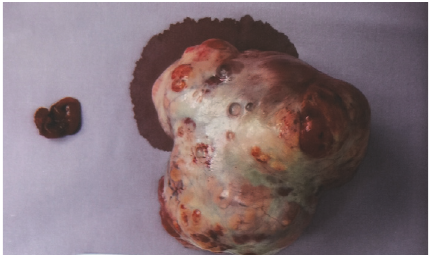
Figure 3: The specimen showed the left ovarian tumour and fallopian tube of the patient. The gross specimen consisted of a lobulated mass 100 x 100 x 30 mm with a defect measuring 20 mm in size externally, altogether weighing 177 grams. The mass had morcellated appearance. On cut section had solid and multi- cystic appearance. The solid areas had a golden yellow appearance punctuated by foci of haemorrhage. A small fleshy tan solid-cystic area was present at one end measuring 20 x 15 x 15 mm. In cytological examination, the sections of the main tumour showed a predominantly diffuse proliferation of polygonal cells with ample, pale, vacuolated cytoplasm and round central nuclei. Small areas of a more nested appearance were also seen. Foci showing cells with more eosinophilic cytoplasm were also evident, but no Reinke crystals were evident. The nuclei were central and round, with no significant atypia. Immunohistochemical stains for calretinin and alpha-inhibin were diffusely and strongly positive. CD 10 is negative. An area showing multiple cystic structures lined by bland cuboidal to columnar epithelium with focal ciliation in a fibromatous stroma was seen. No significant epithelial proliferation or atypia was